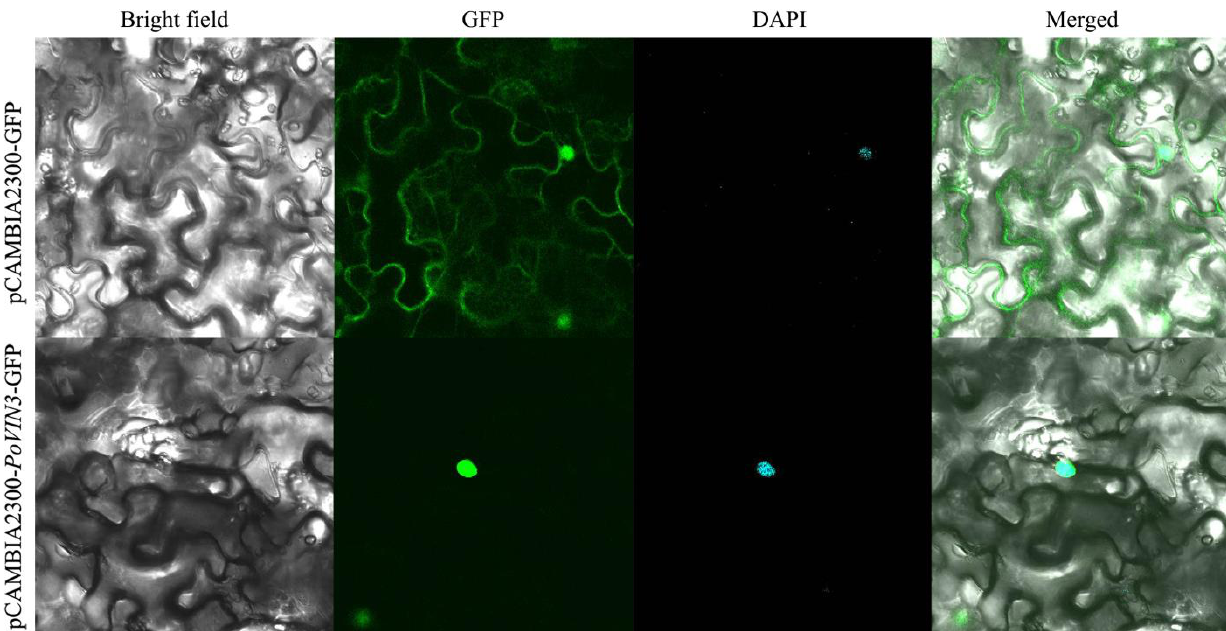
Figure 4. Subcellular localization of GFP fusions of PoVIN3 .